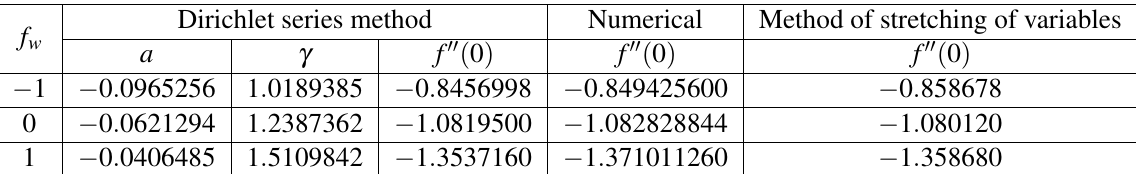
Table 1 Various values of suction or blowing parameters f w obtained by Dirichlet series and method of stretching of variables with their numerical values for M =